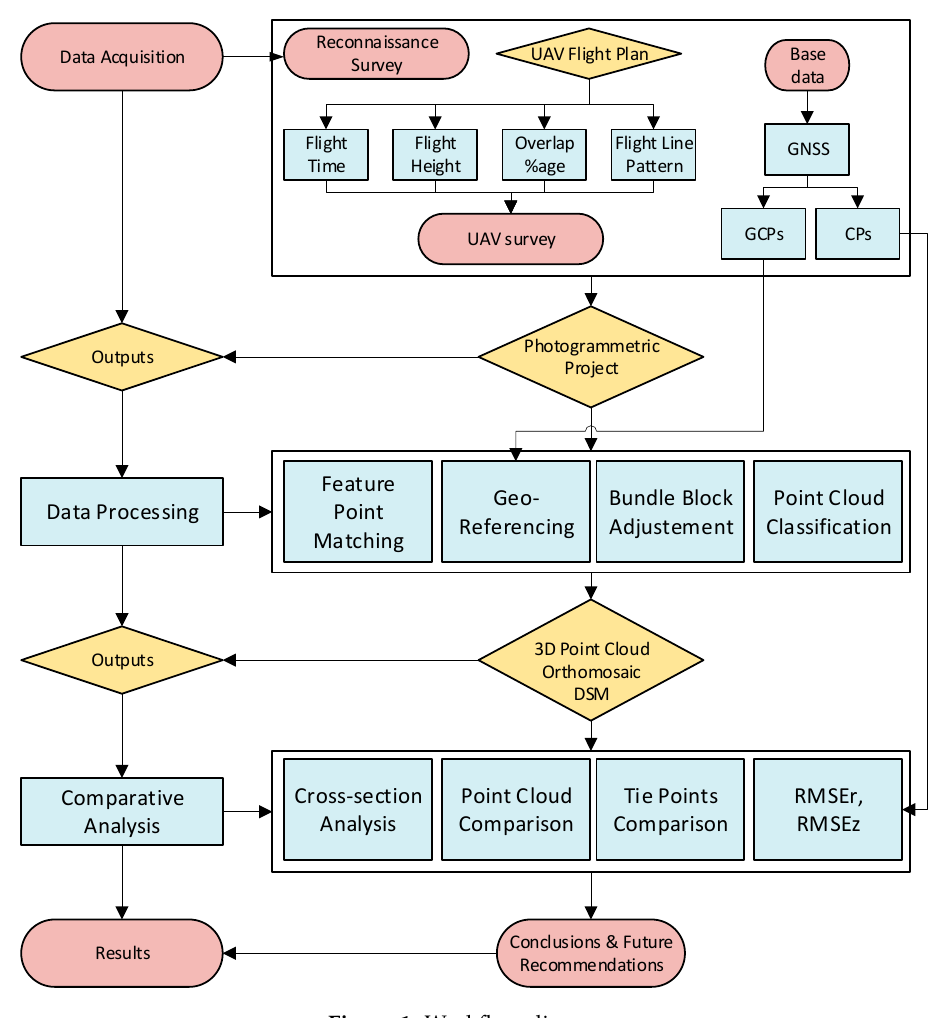
Figure 1. Workflow Figure 1. Workflow diagram.